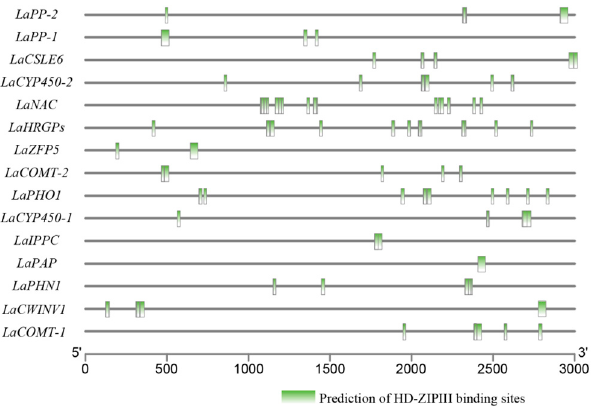
Figure 10. Prediction of HD-ZIP III-binding sites in the promoters of the related genes, based on the transcriptomic analysis of Larix kaempferi. Green segments: predicted binding sites.